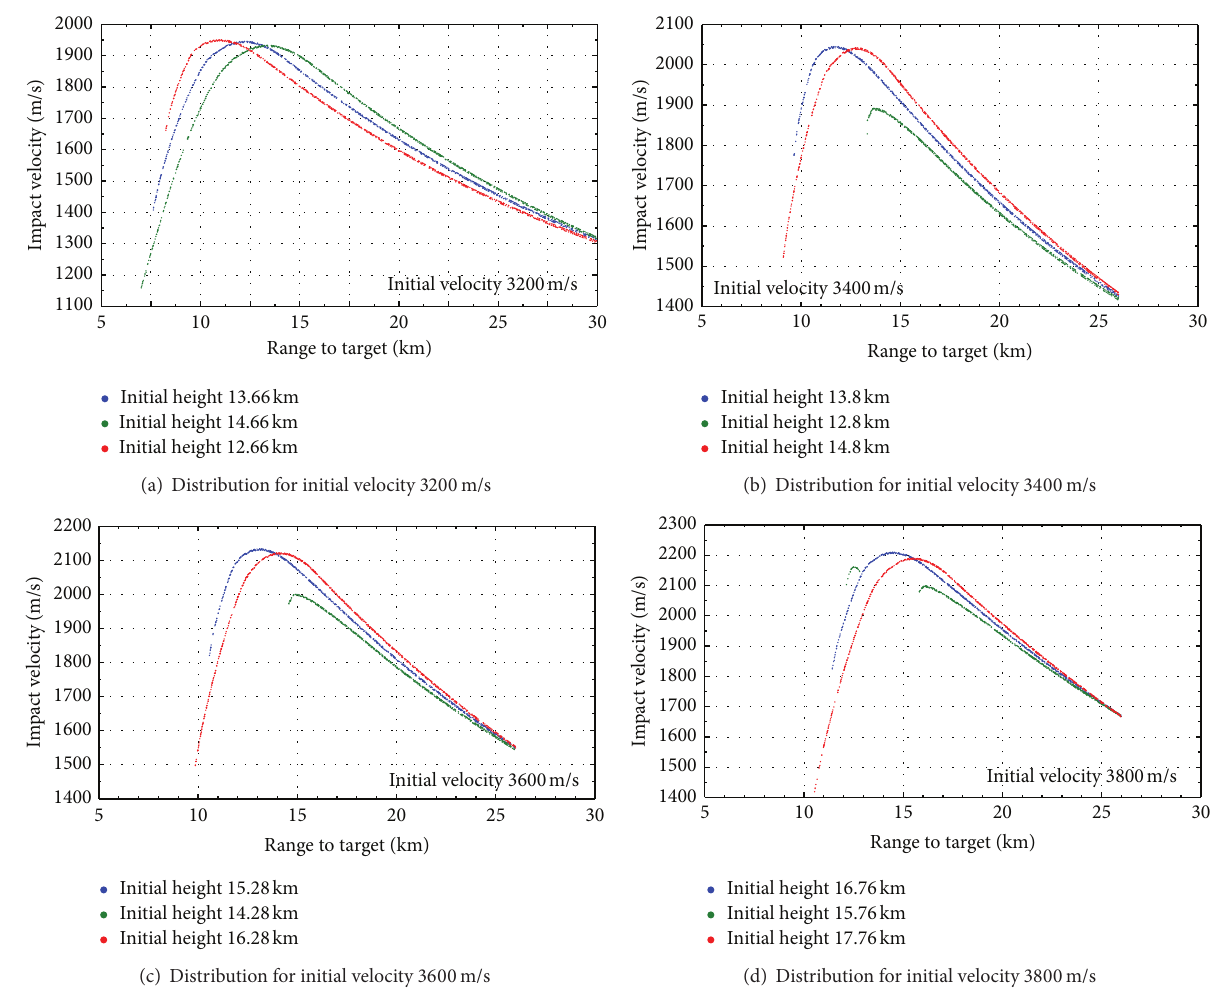
Figure 2: Distribution of the impact velocity and range to target computed by Monte Carlo method.